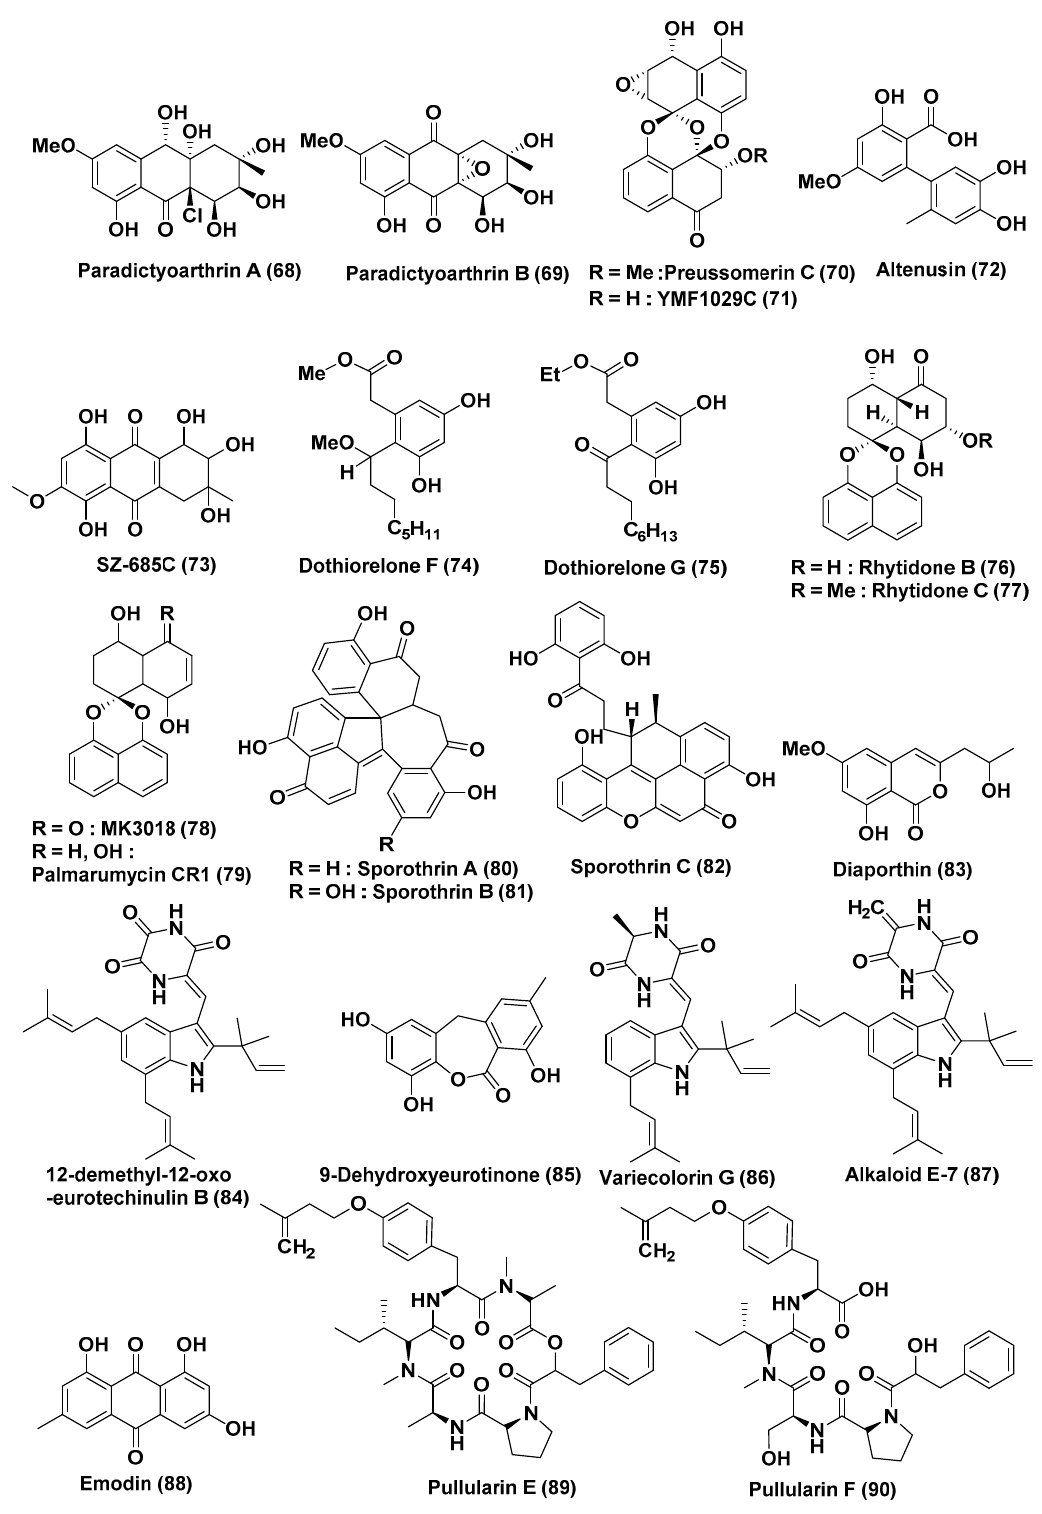
Figure 5. Structures of metabolites isolated from Ascomycetes ( 68 – 90